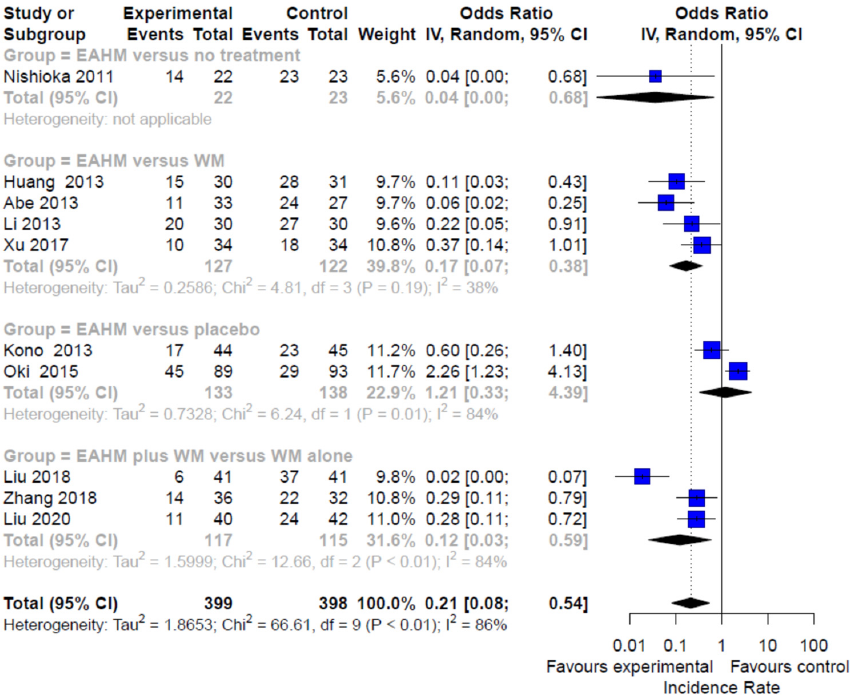
Figure 10. Forest plot of the trials reporting the effect of East Asian herbal medicine monotherapy on the incidence rate for peripheral neuropathy.